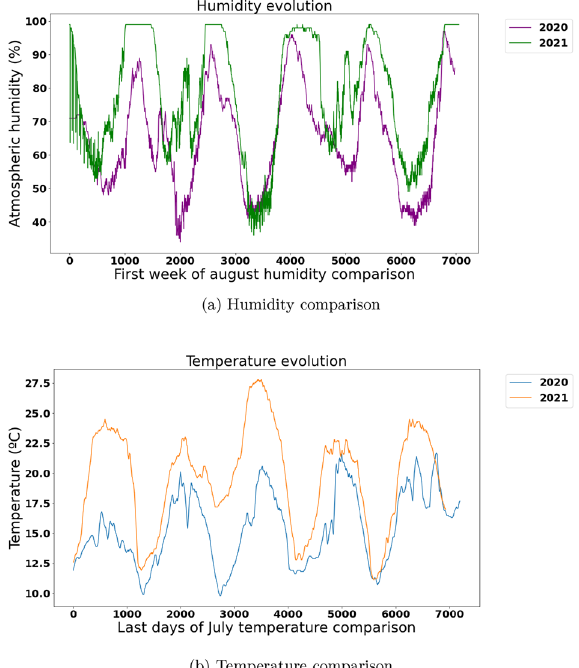
Fig. 12 Comparisons of humidity and temperature between 2020 and 2021 (output provided by the STSDaMaS query